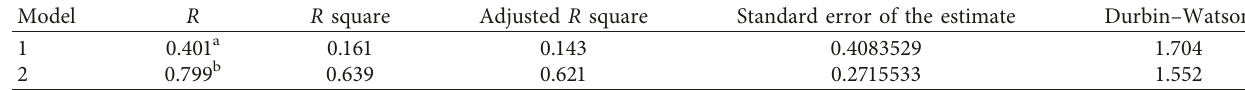
Table 4: Results of regression analysis with regard to Model 1, 2.